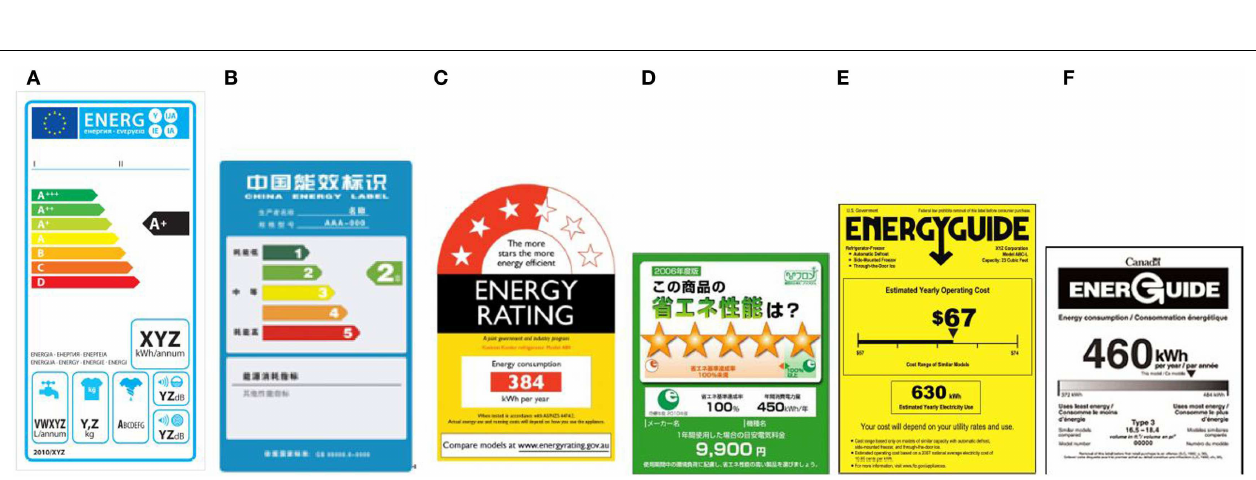
FIGURE 3 | Comparative labels – (A): EU Energy Label, (B): Chinese Energy Label, (C):Australian Energy Label, (D): Japanese Energy Label, (E): US EnergyGuide, (F): Canadian EnerGuide .